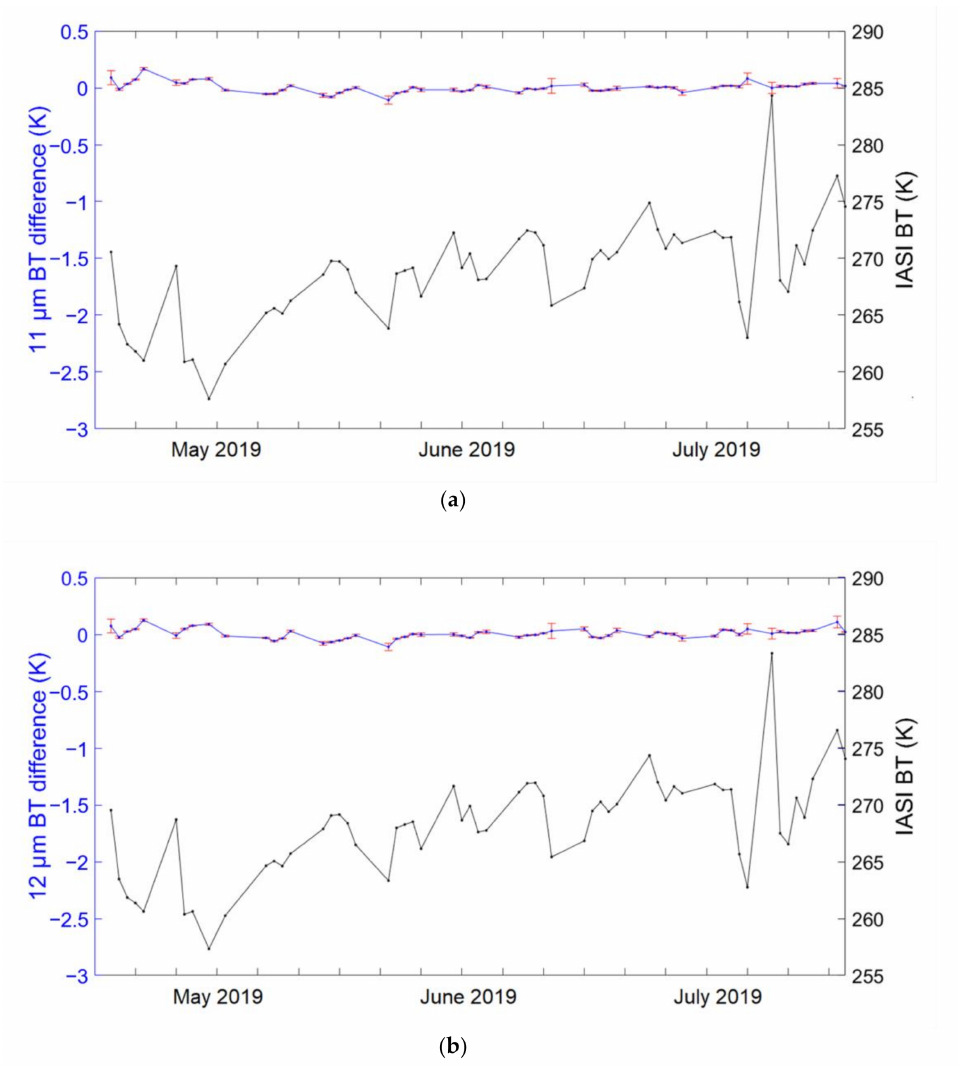
Figure 13. The time series plots of the COCTS-corrected BT minus IASI BT difference from May to July 2019 for the ( a ) 11 and ( b ) 12 µ m channels. The upper blue lines show the variations in the daily mean differences, accompanied with the red vertical bars indicating the daily uncertainties in the mean, corresponding to the left y -axis. The lower black lines represent the mean values of the IASI daily BTs corresponding to the right y